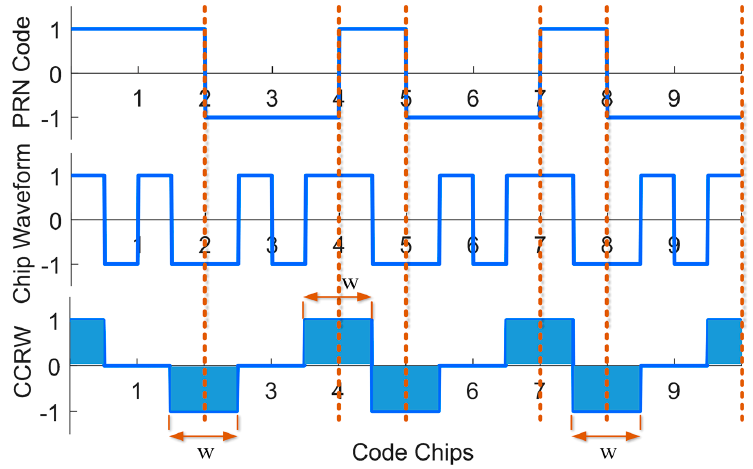
Figure 8. Illustration of CCRW method used in the following simulations.